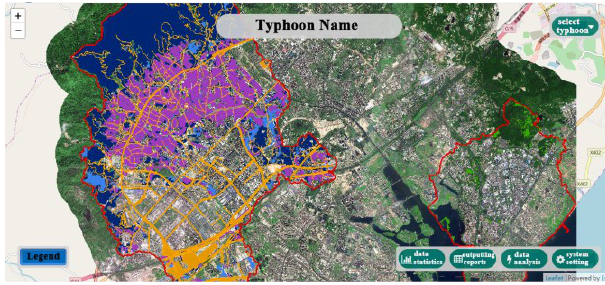
Figure 3. The main interface map module of the system